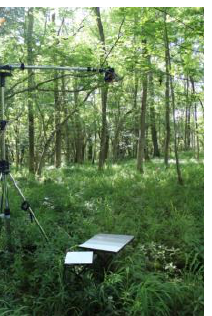
Figure 2. The FPI camera setup in terrestrial measurement.